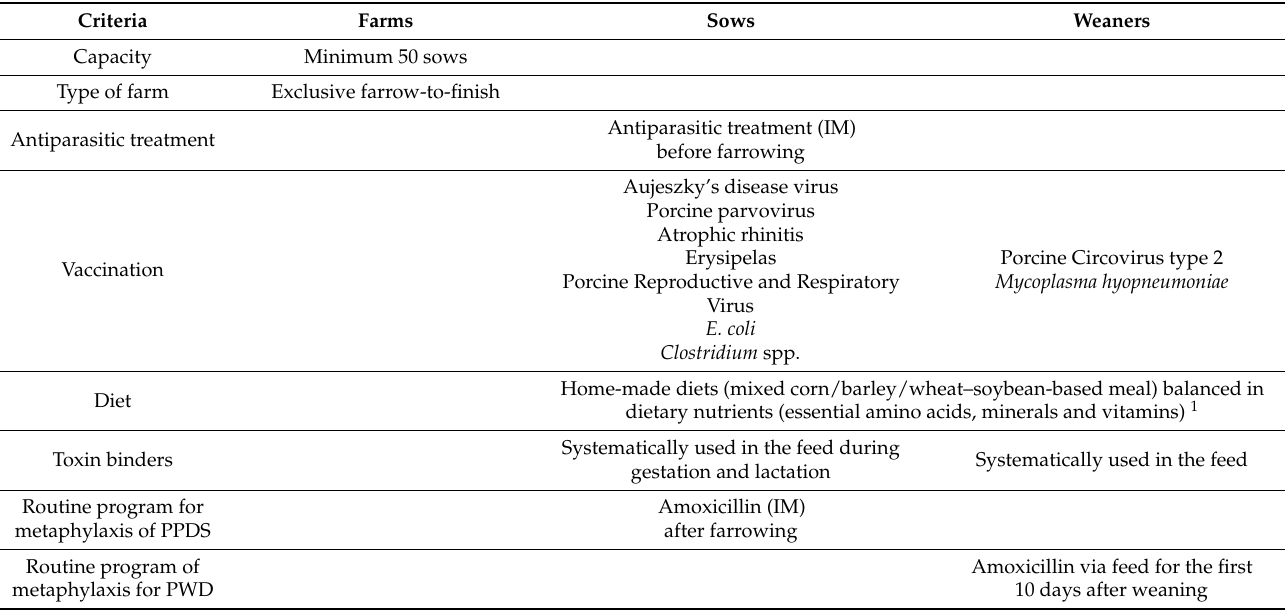
Table 2. Criteria for farms